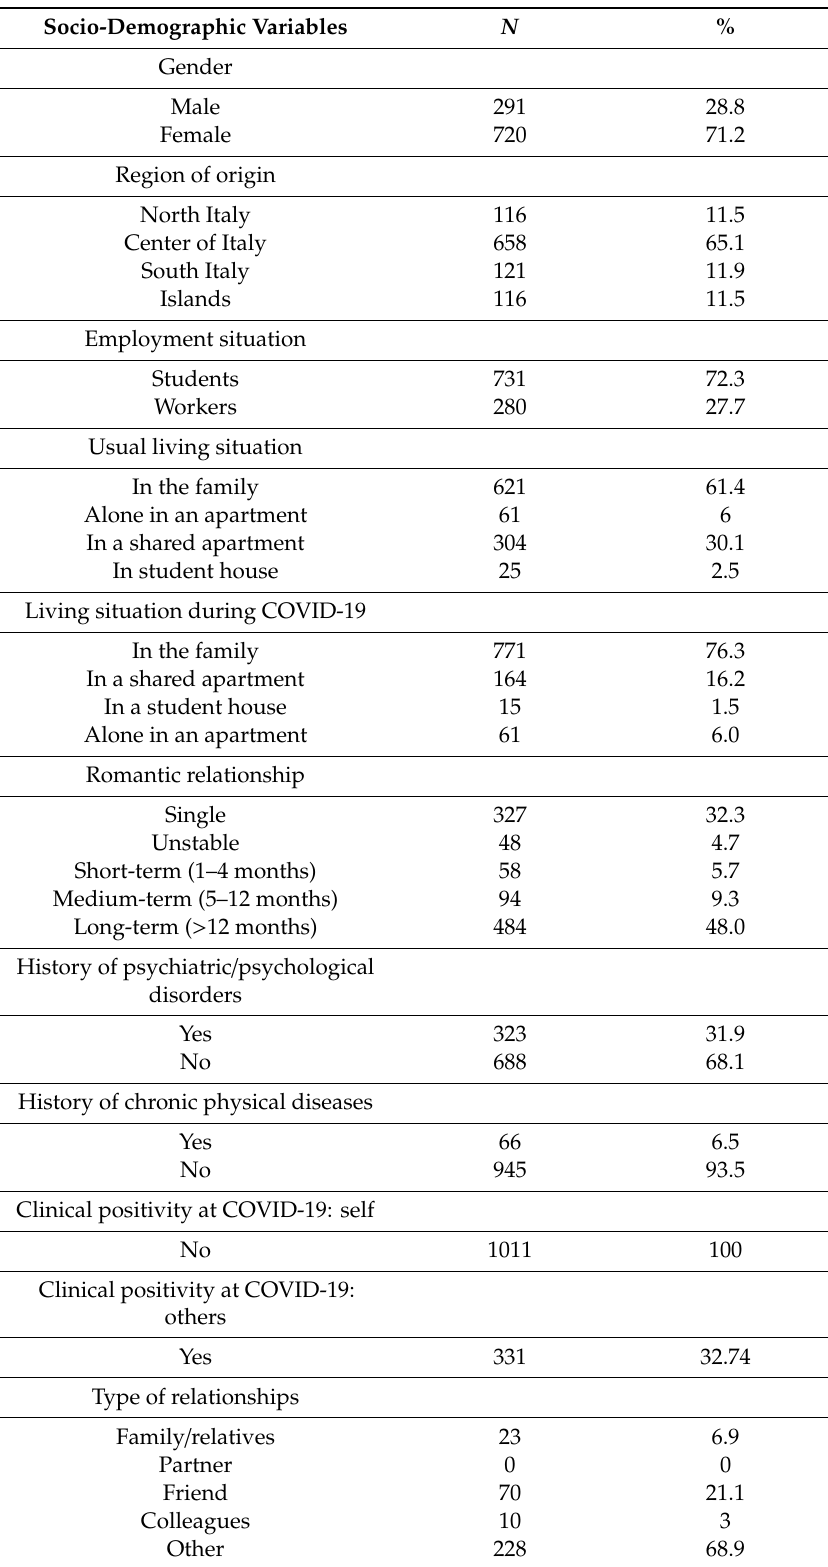
Table 1. Descriptive statistics of socio-demographic